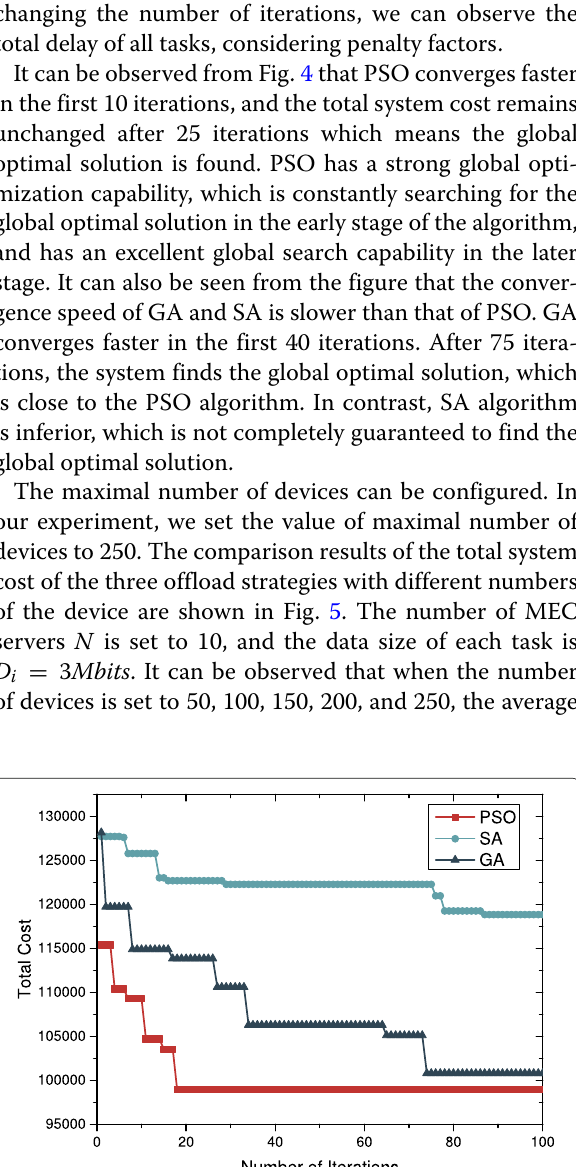
Fig. 5 Comparison of the total cost of the three offloading strategies under different numbers of devices